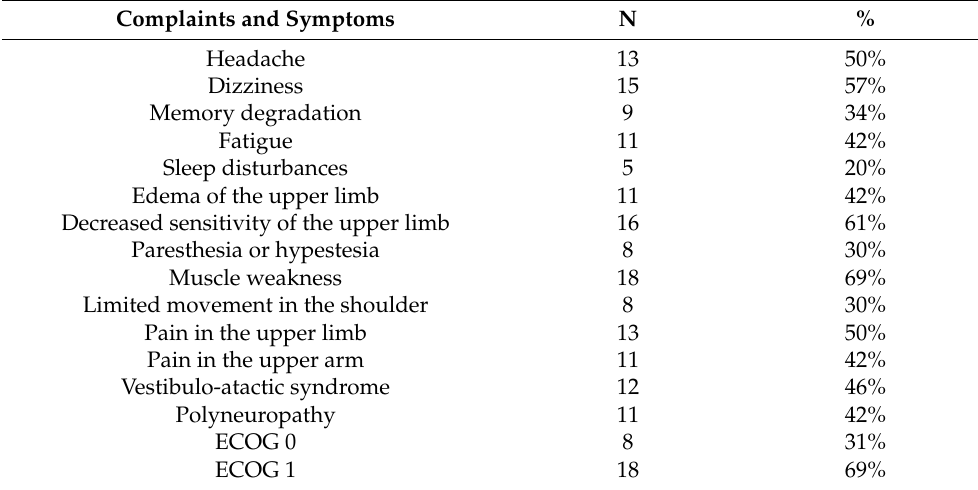
Table 2. Symptoms and complaints in patients after BC treatment.